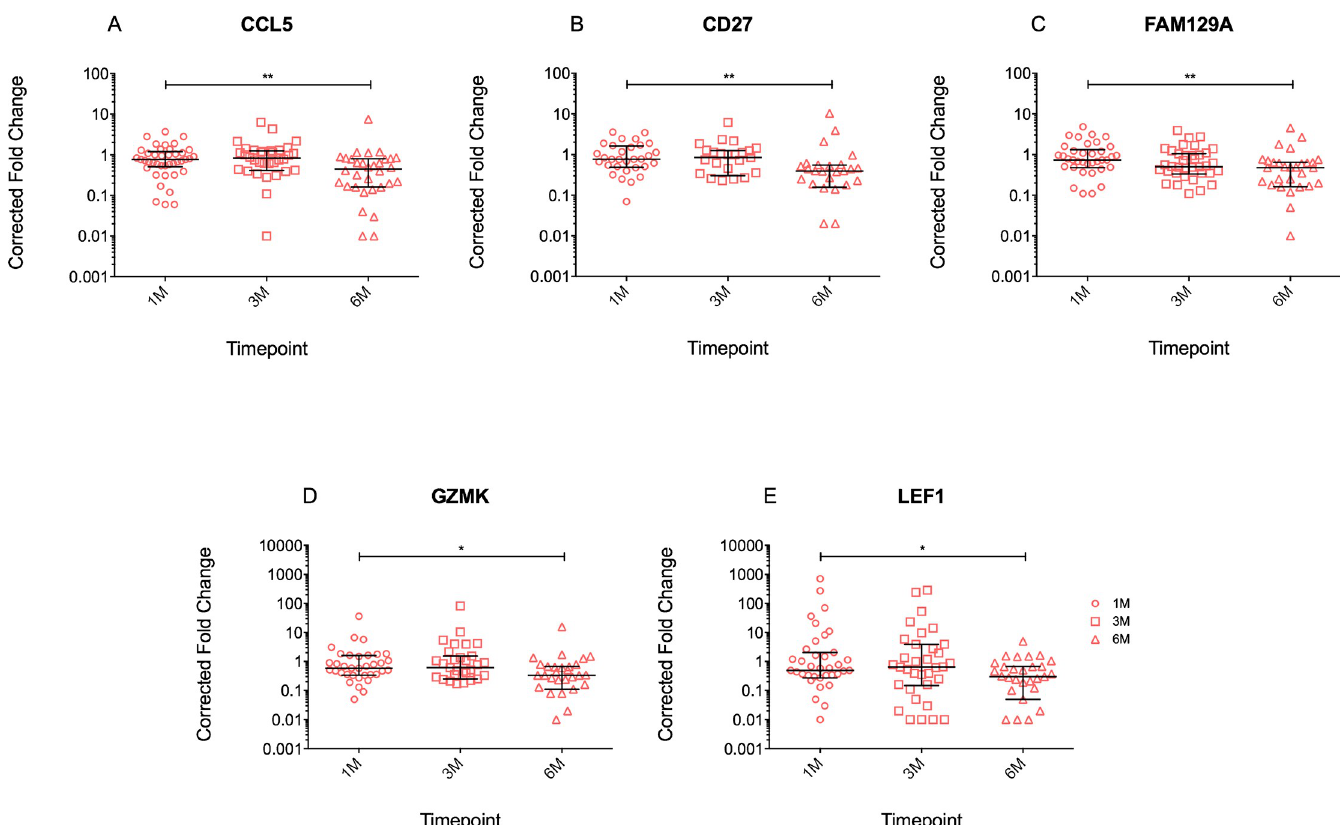
Fig 4. Fold change of gene expression at 1M, 3M and 6M of ART, for the genes that showed significant change over time both with and without correction for increasing CD4 count.